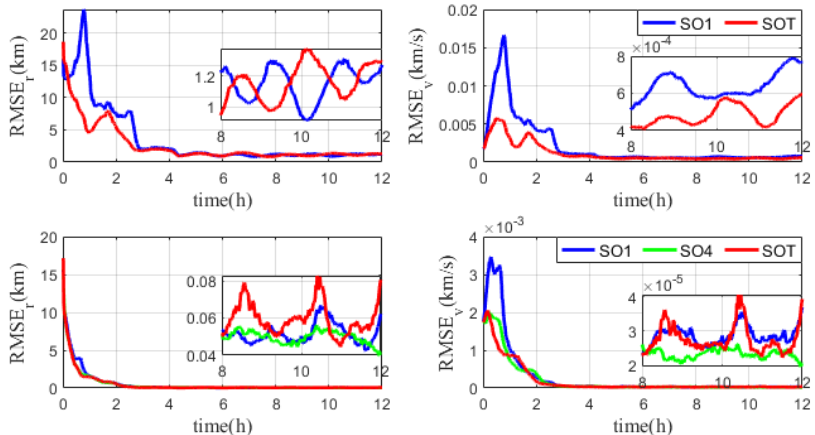
Figure 10. RMSE results of Monte-Carlo simulations .